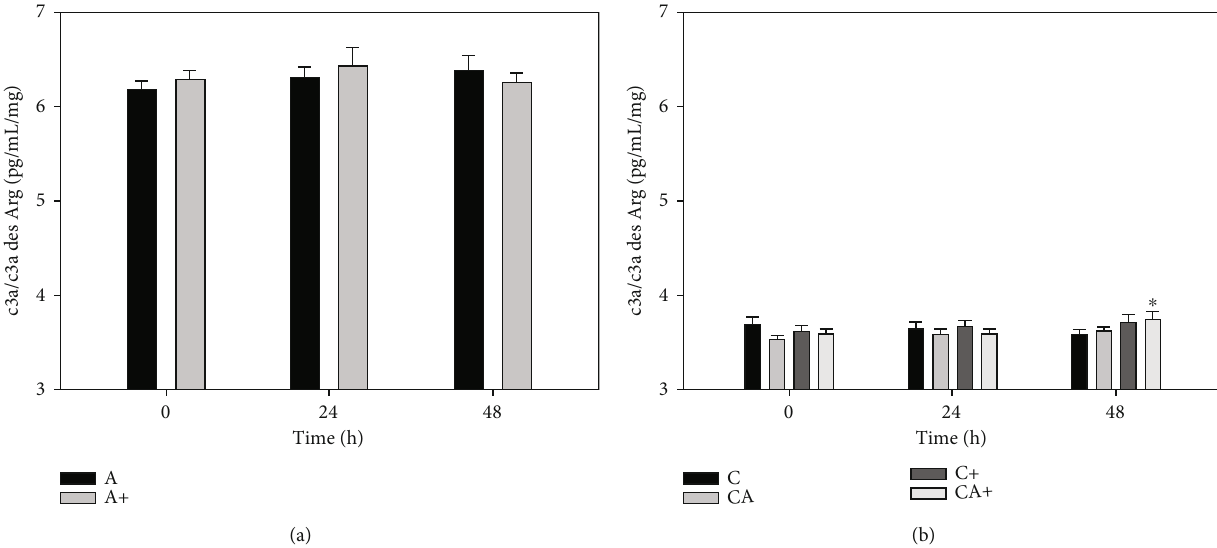
Figure 3: c3a/c3a des Arg production by adipose tissue explants (a) and cartilage explants (C) cultured in the presence or absence of adipose tissue explants (A) (b) with or without LPS (+; 10 μ g/mL). Data represent duplicate samples from 8 market-weight pigs. ∗ Denotes signi fi cant change from 0 h within a single treatment group ( p < 0 : 05